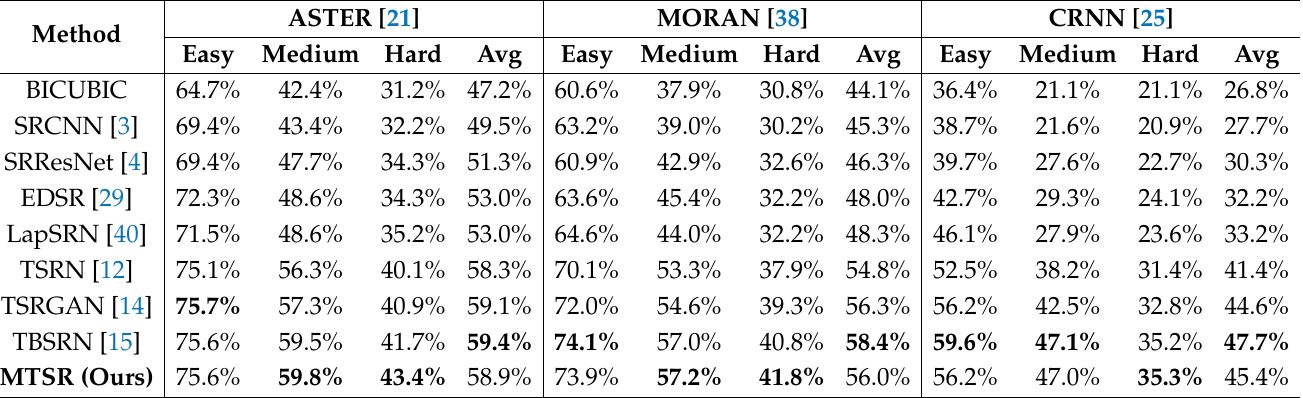
Table 4. Comparison of recognition accuracy on the TextZoom dataset [12]. “Avg” indicates average accuracy in all subsets.